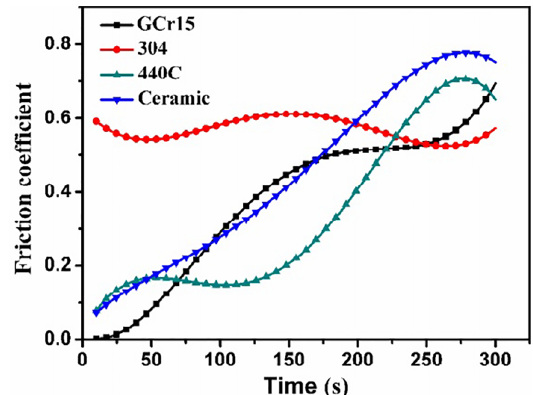
Figure 6. The variation of the friction coefficient for 9Cr18Mo and different secondary frictional pairs The mass of the 9Cr18Mo sample before and after the test was measured by an electronic balance in